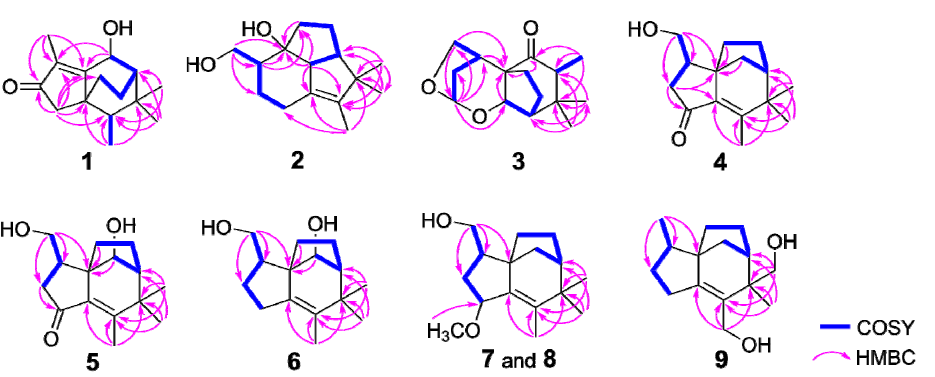
Figure 2. Key COSY and HMBC correlations for compounds 1 – 9 .